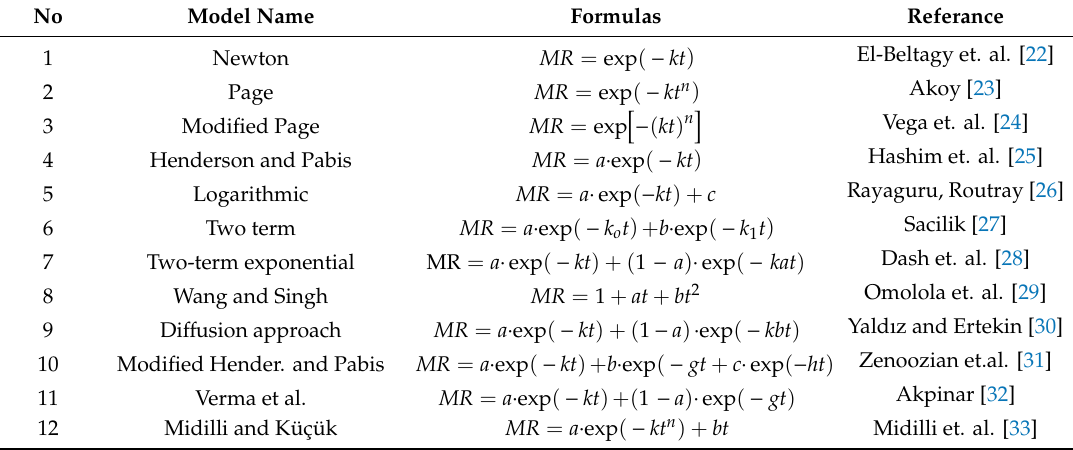
Table 4. Some drying curve models in the